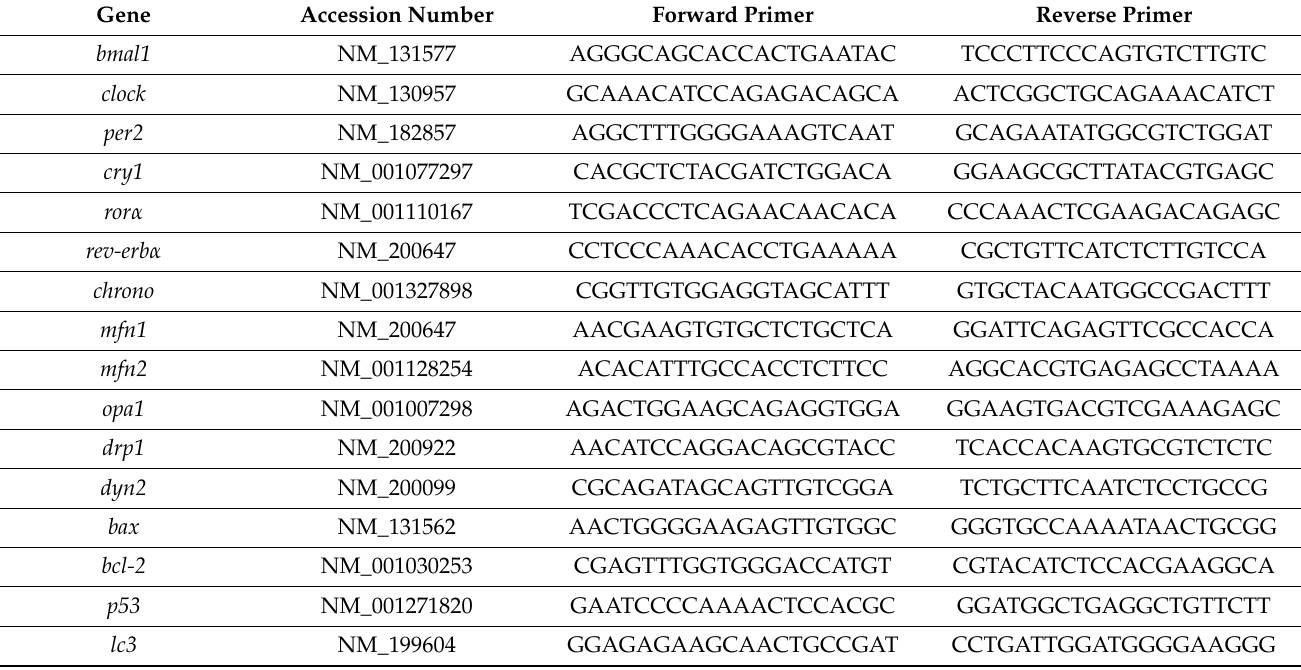
Table 1. Forward and reverse sequencies of the primers used for